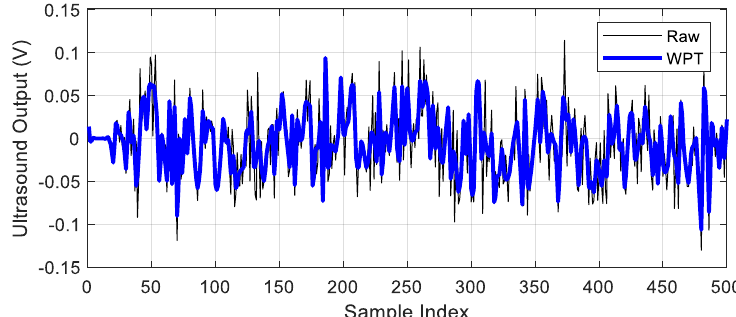
Figure 2. Comparison between original and rebuild signal using Wavelet Packets Transform (WPT).